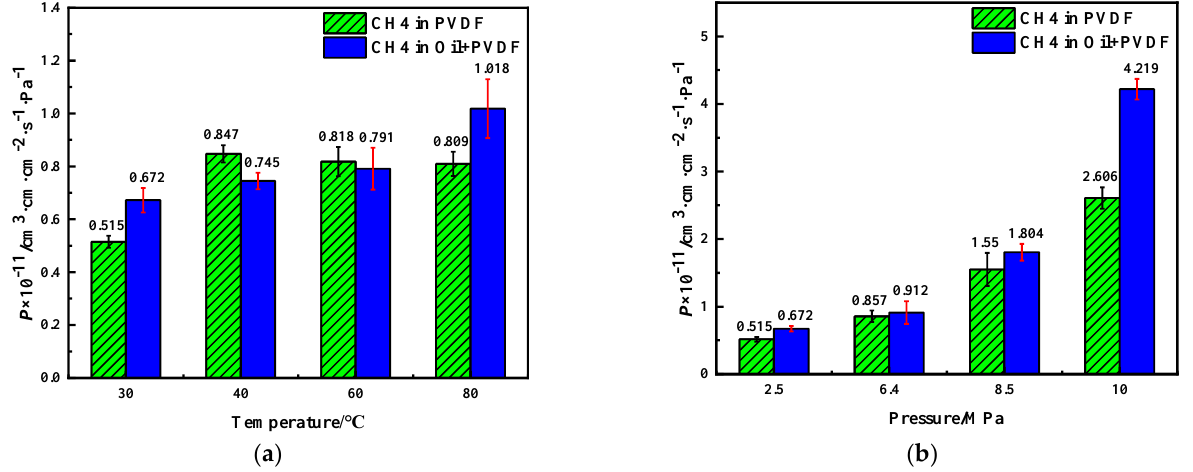
Figure 11. Permeability coefficient of CH 4 in PVDF under different conditions: ( a ) 2.5 MPa, ( b ) 30 °C.